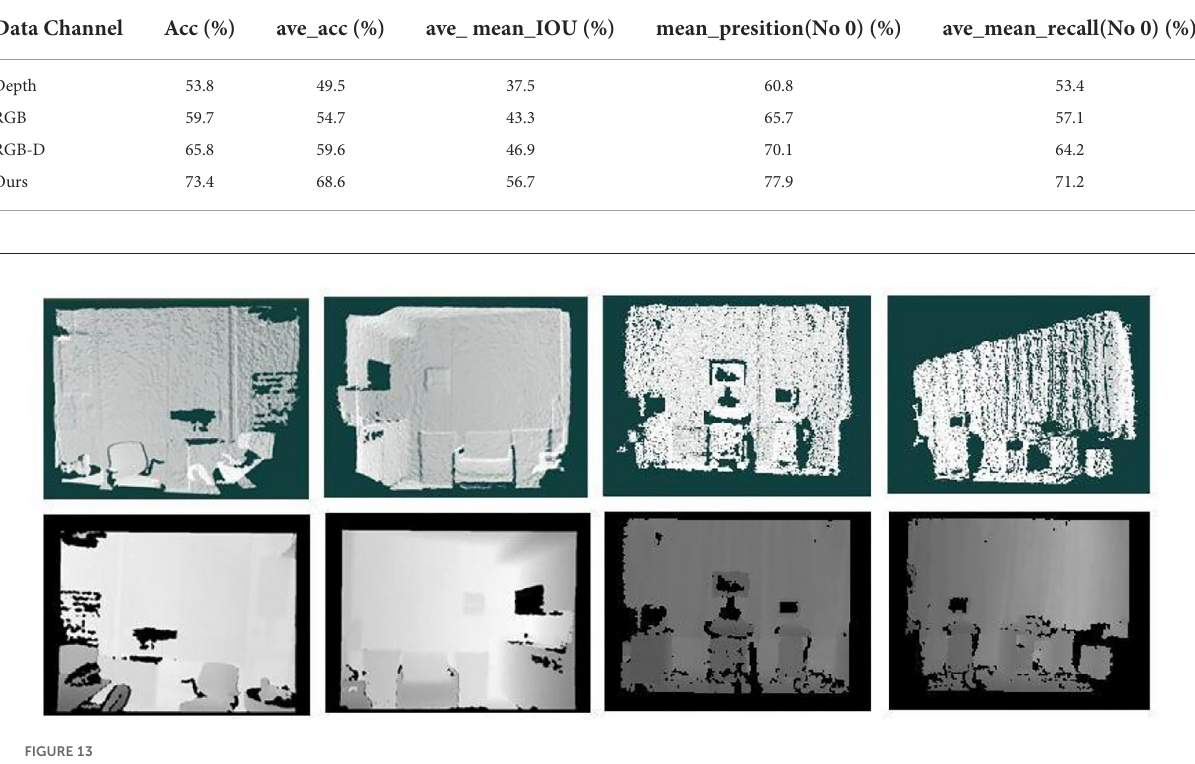
TABLE 3 Comparison of evaluation metrics for dual data streams and different channel data.